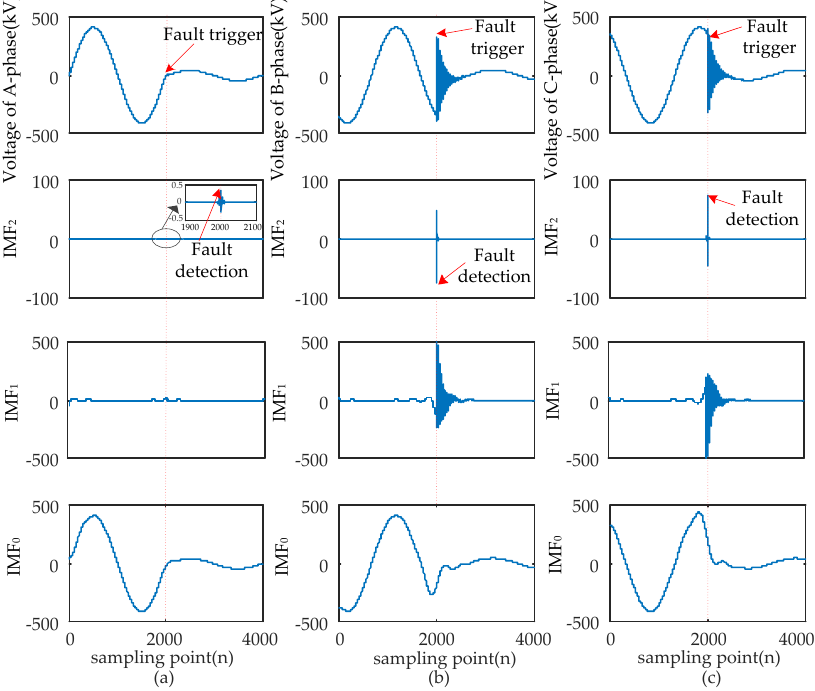
Figure 8. ABC fault signal’s modes extracted by the EWT are shown as follows: ( a ) A-phase voltage and its IMFs; ( b ) B-phase voltage and its IMFs; ( c ) C-phase voltage and its IMFs.